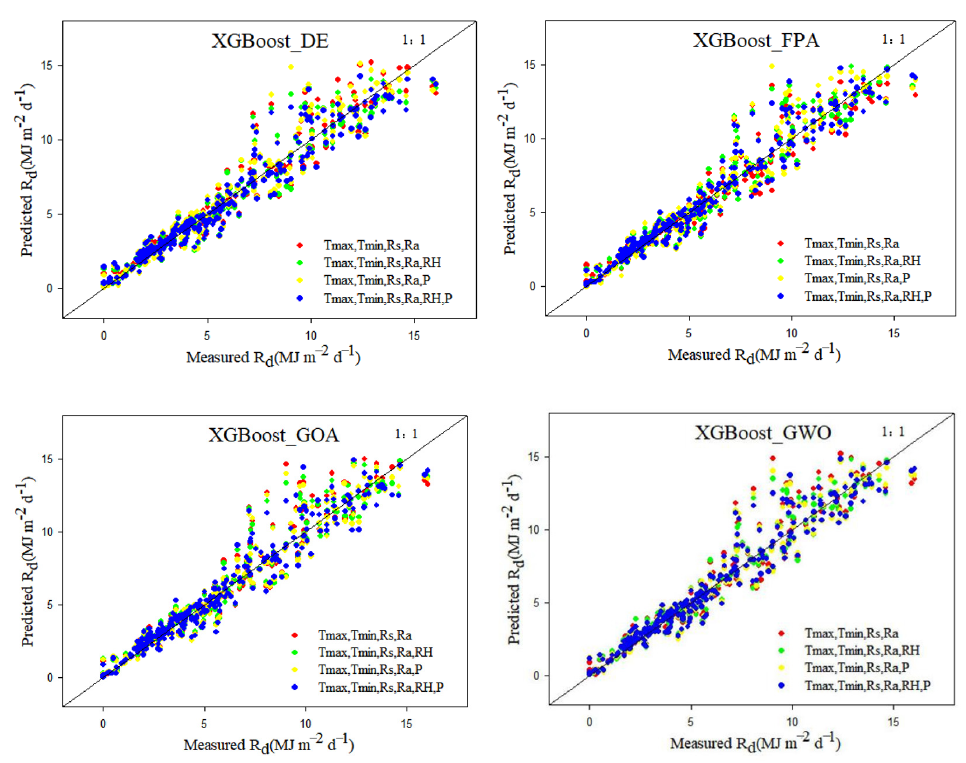
Figure 4. Scatter plots of R d predicted by the coupling models based on ground weather station data in Beijing.